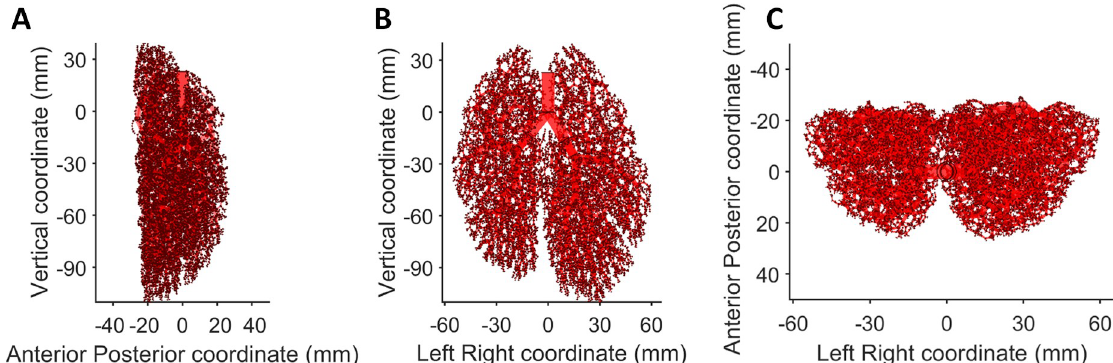
Fig 7. Computational minipig bronchial tree. It is represented as a tubular structure. Each conducting airway is represented by an empty cylinder. Three axial planes are shown: (A) Sagittal plane, (B) Coronal plane, and (C) Axial plane.